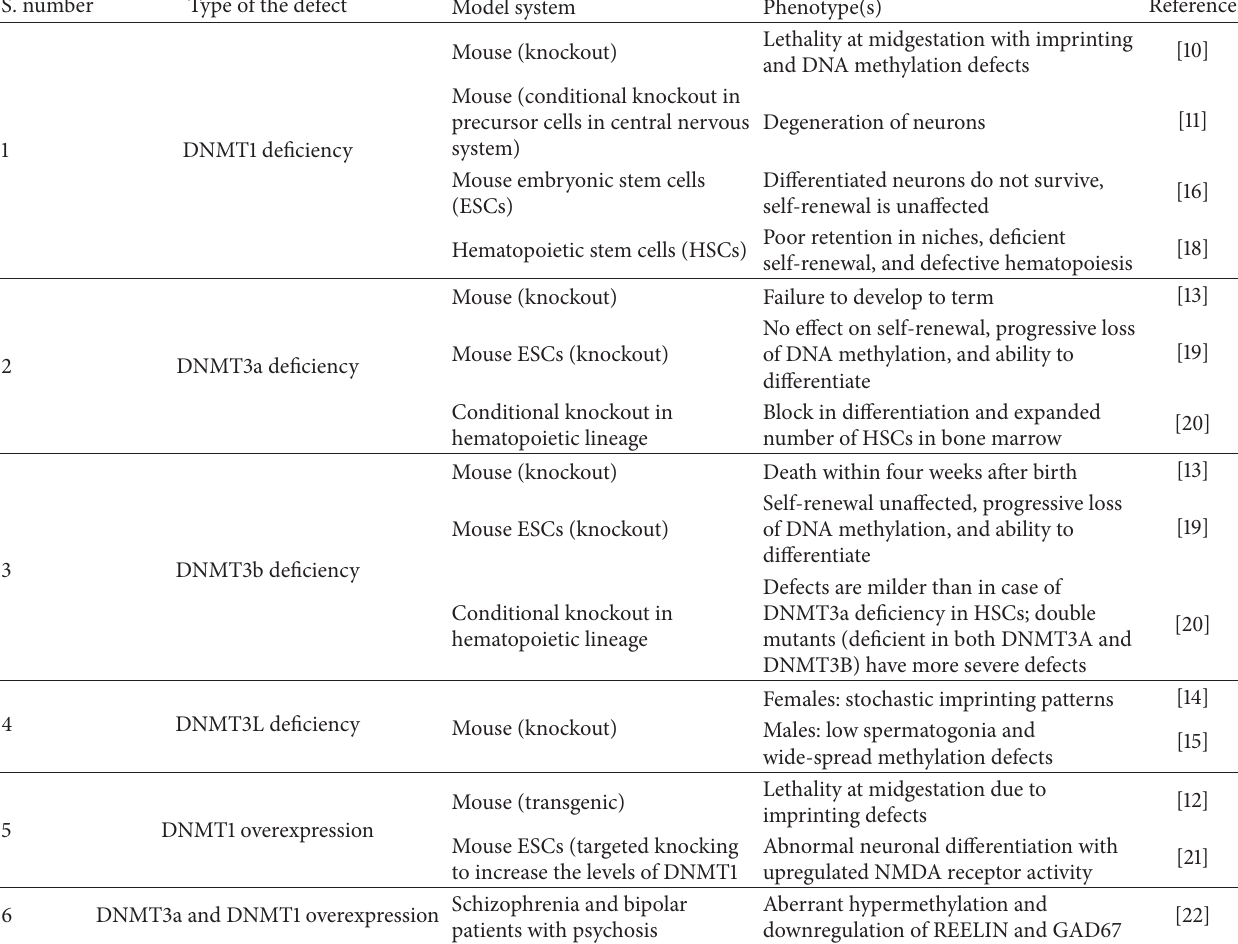
Table 1: Effects of DNMT deficiency and overexpression in